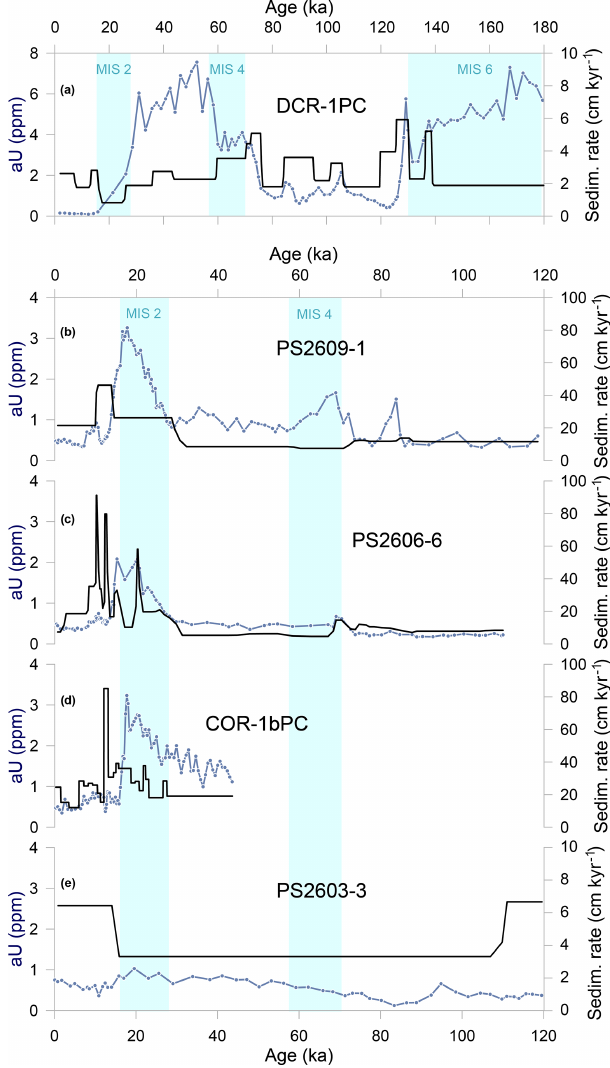
Figure 5. (a–e) Sedimentation rates (in black) and authigenic ura- nium concentrations (in light blue) in all cores from north to south. Light blue bars show cold periods MIS 2, 4, and 6 (Lisiecki and Raymo,